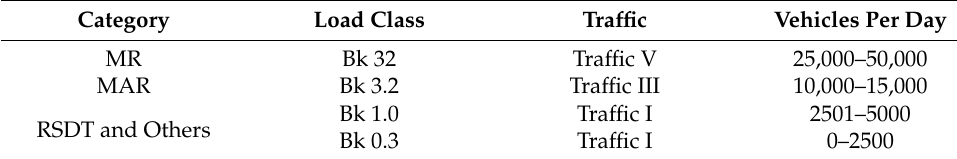
Table 2. Pavement structures applied in Munster according to the